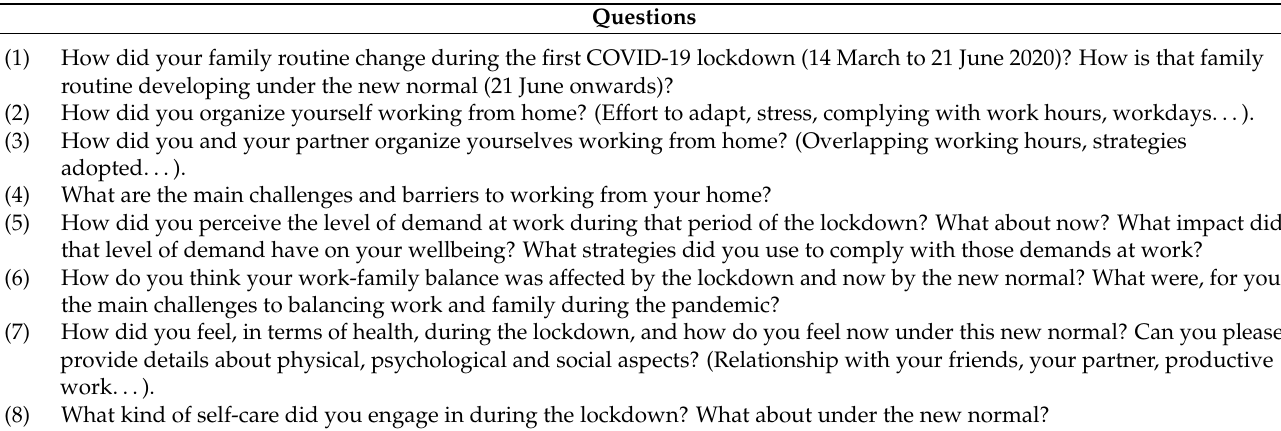
Table 2. Interview script for the semi-structured